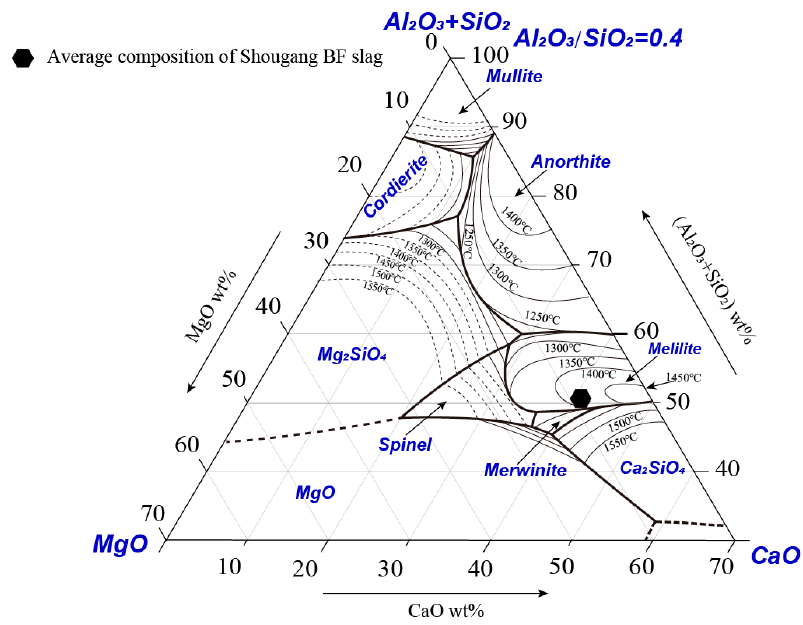
Figure 14. Experimentally determined pseudo-ternary phase diagram CaO-MgO-(Al 2 O 3 + SiO 2 ) at a constant Al 2 O 3 /SiO 2 ratio of 0.4 [22].